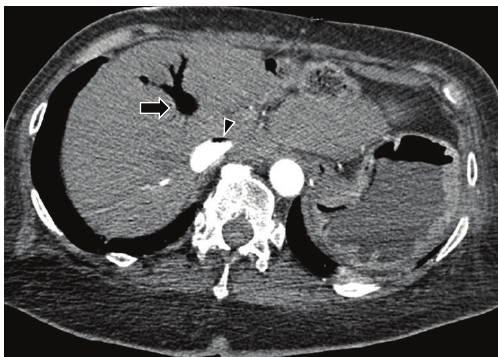
Figure 3: CT image of the liver shows air in the hepatic veins ( arrow ) and air-contrast level in the inferior vena cava ( arrowhead ).